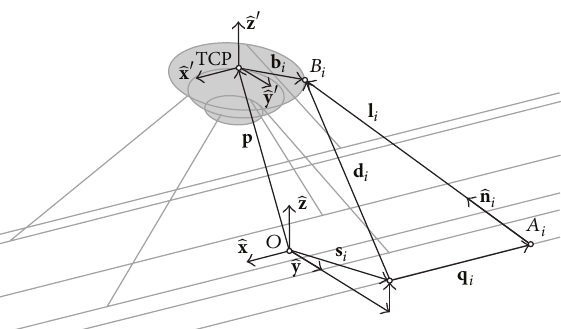
the same sequence of joints: actuated prism (P), universal (U), and spherical (S). The links have a fixed length, while the actuation takes place through linear guideways, which are not necessarily on the same plane but lie on parallel